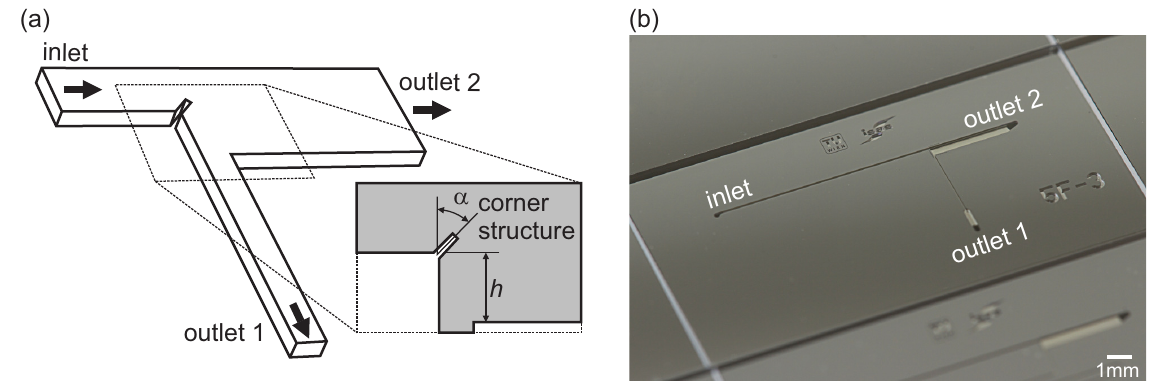
Figure 1. ( a ) Schematic of the microfluidic chip showing the backward-facing step and the novel corner structure in detail (angle of corner structure α , step height h ); ( b ) Photograph of a fabricated